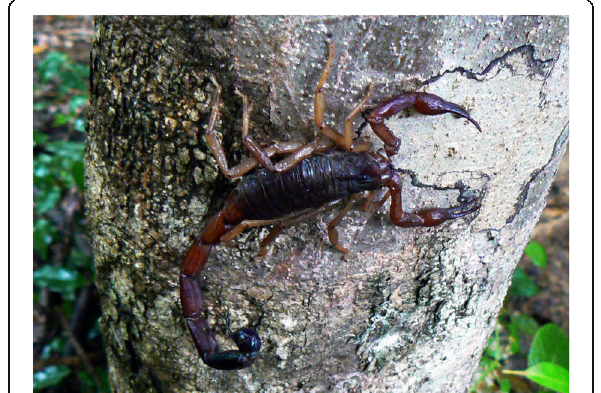
Fig. 11 Grosphus ankarana Lourenço & Goodman (Buthidae). Female from the north of